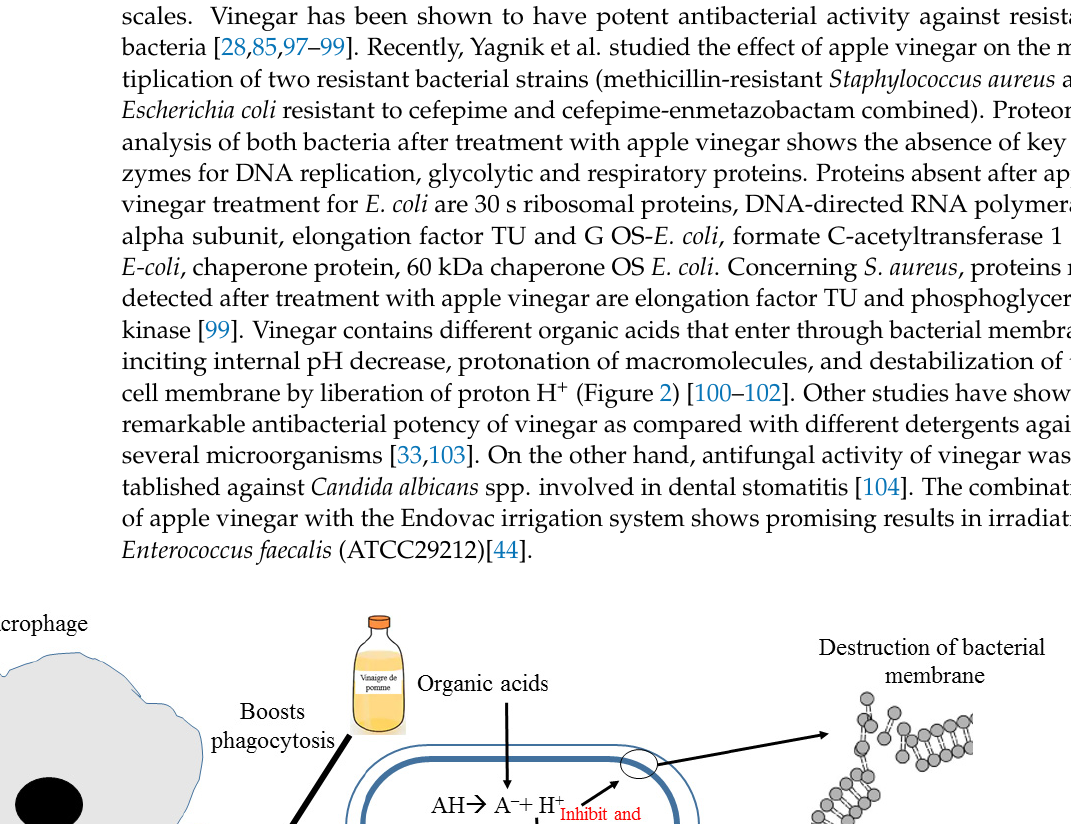
Figure 2. Mechanism of action possible of apple vinegar against pathogenic bacteria.